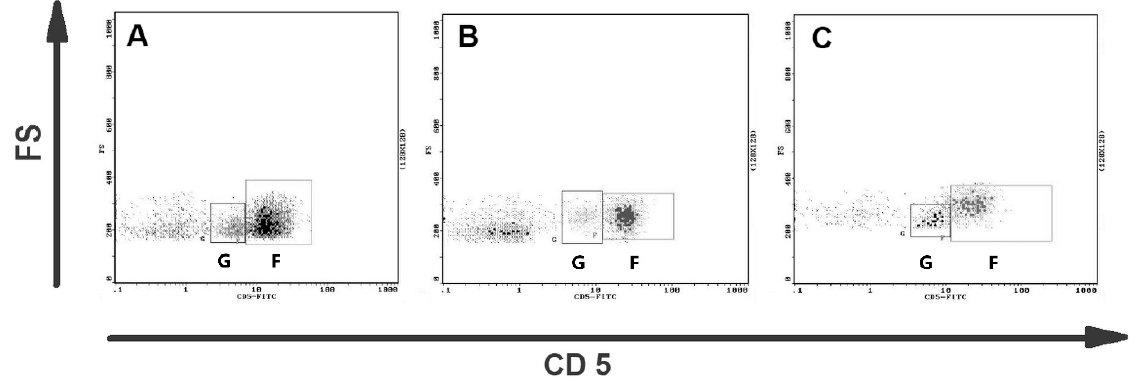
Figure 2. Representative flow cytometric analysis of CD5+ lymphocytes in blood of bitches with malignant mammary tumors. Dot plots showing CD5 expression on canine lymphocytes from ( A ) the healthy bitch, ( B ) the bitch with osteosarcoma, and ( C ) the bitch with complex carcinoma G2. Two subpopulations of CD5+ lymphocytes are visible: CD5 low lymphocytes (gate G) and CD5 high lymphocytes (gate F).